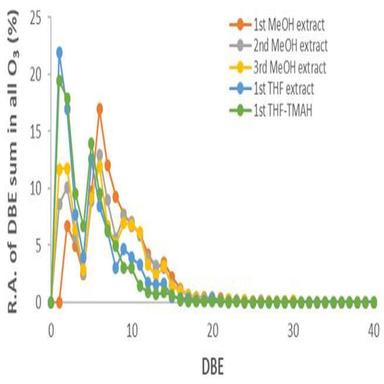
Possible layered distribution of acidic CxHyO3 species on reservoir rock.